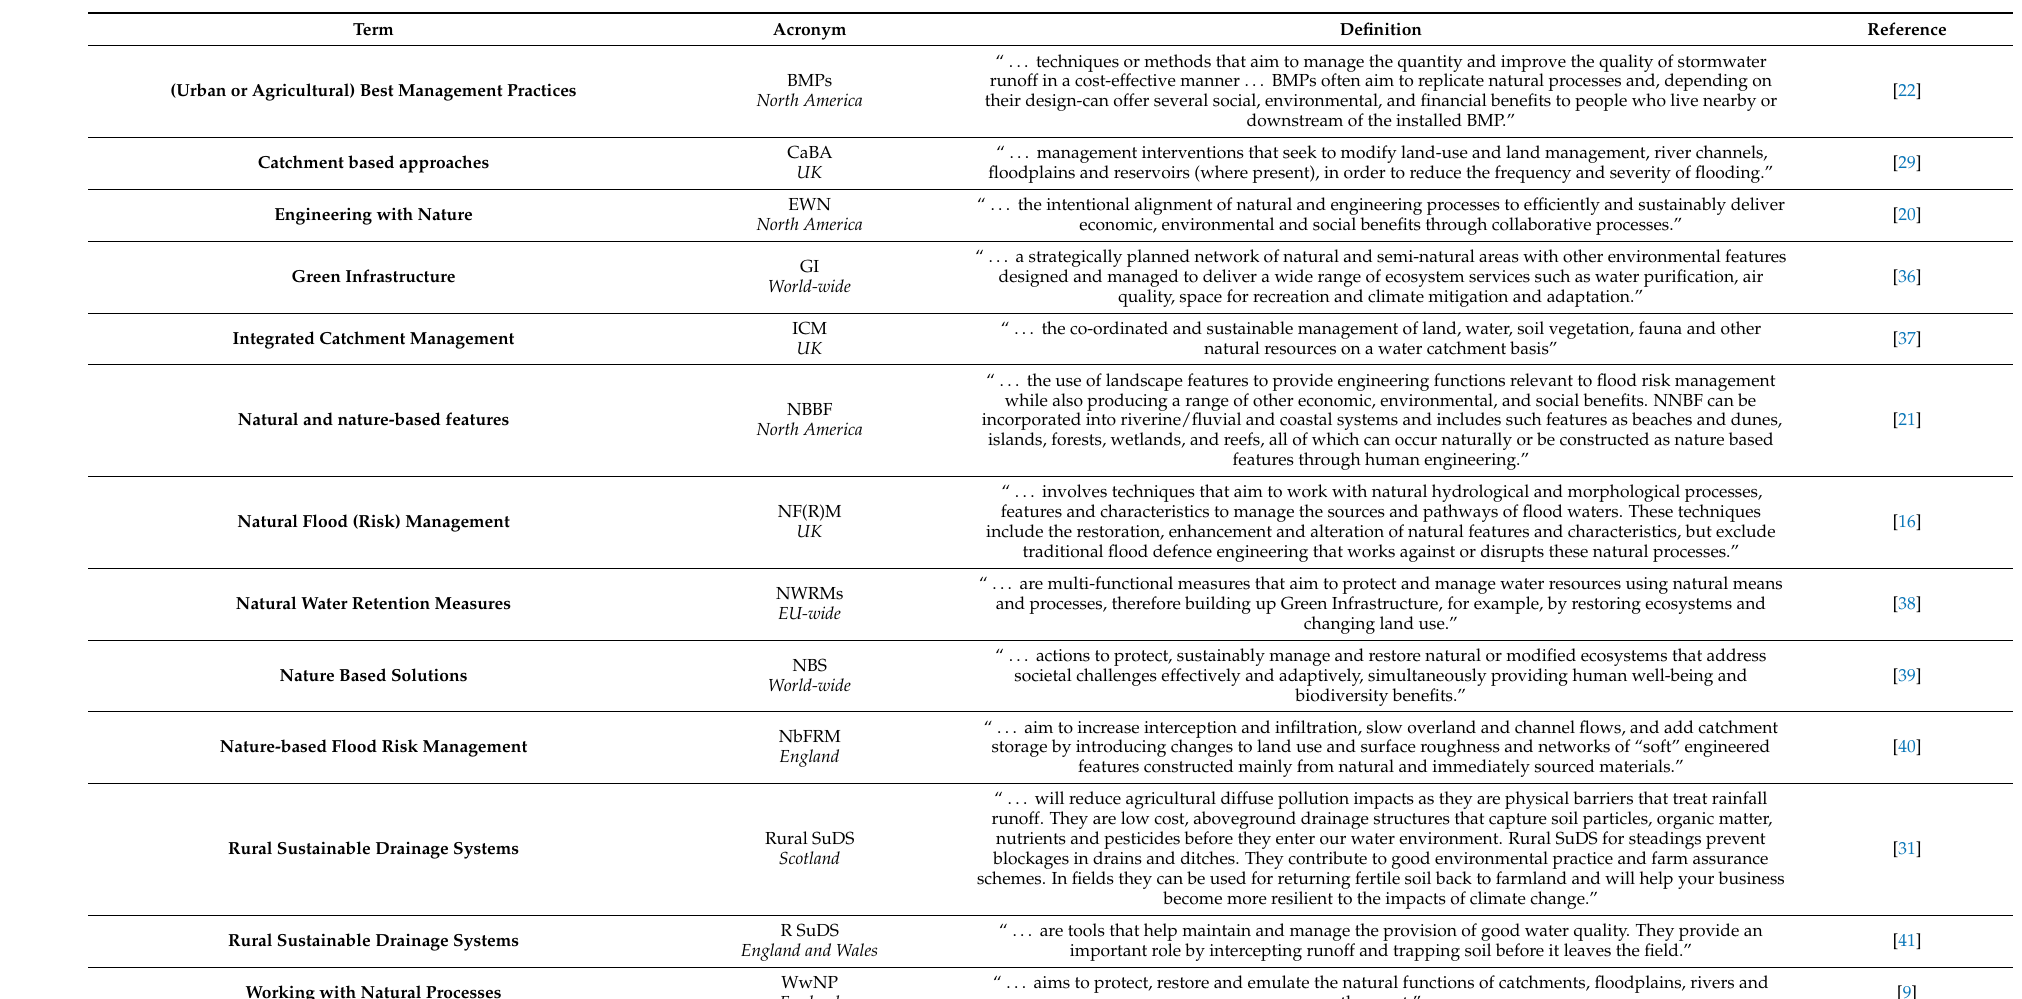
Table 1. National and international terms of reference for